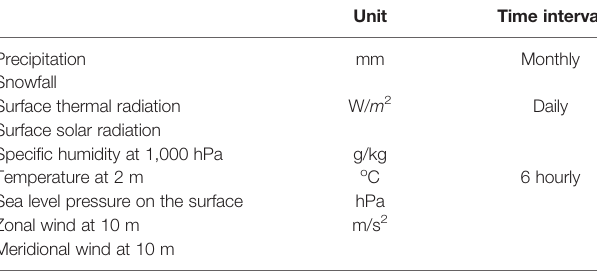
TABLE 2 | Time and unit format of the atmospheric forcing variables fi le entered into the MOM5 model as input.